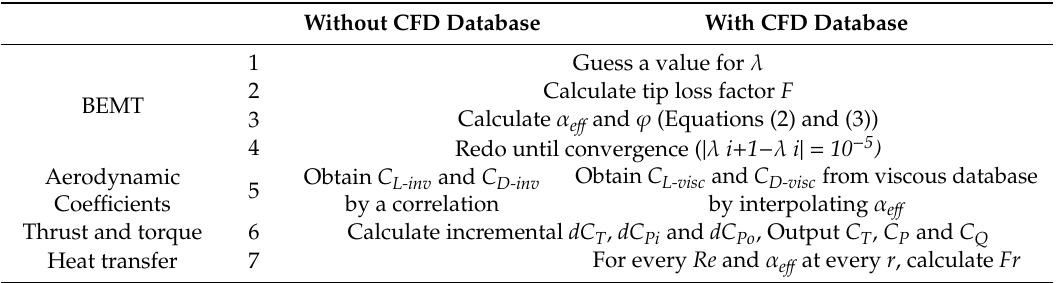
Table 1. Blade element momentum theory (BEMT)-rotor heat transfer (RHT) solution procedure. Without CFD